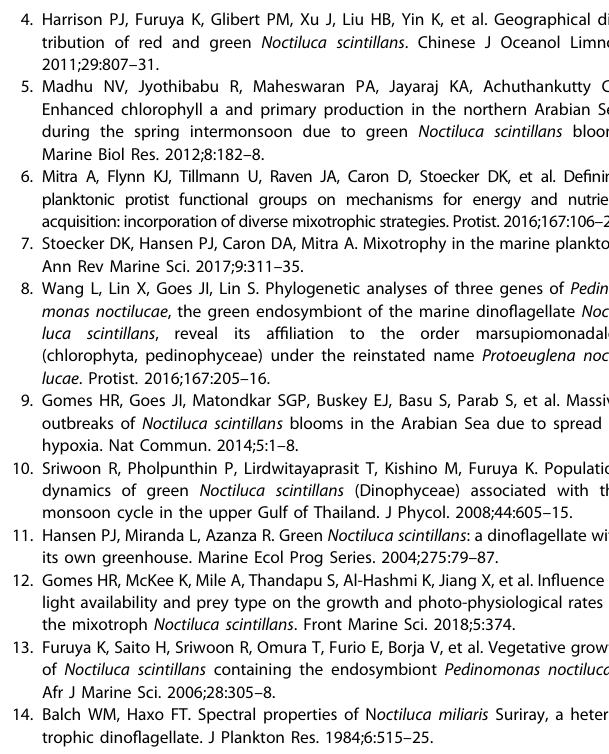
Fig. 5 Schematic of a “ positive feedback loop ” nutrition strategy and sexual reproduction that promote the formation and maintenance of g Noctiluca blooms. The process by which nutrients fi rst accumulate in gNoctiluca cells primarily via grazing, and are then released into the ambient environment during the sexual reproduction phase, to be then used by diatoms or dino fl agellates and ultimately back to support the growth of gNoctiluca , constitutes a positive feedback nutrient loop. Accumulation of ammonium may potentially stimulate the initiation of sexual reproduction of g Noctiluca , contributing to the outbreak of